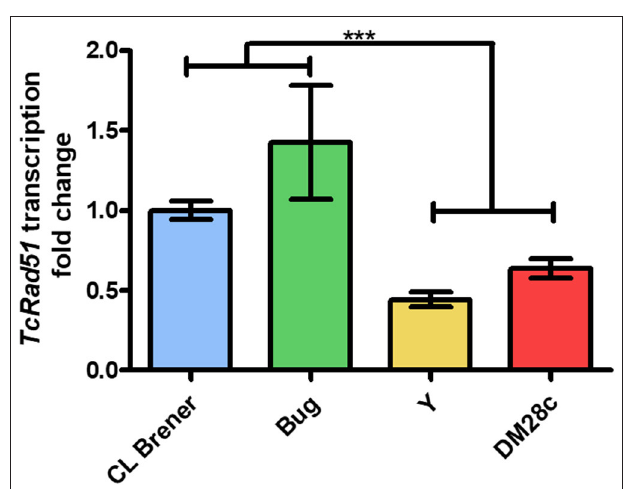
FIGURE 6 | Relative expression of TcRAD51. Fold change of TcRAD51 transcription using CL Brener strain as control strain using qRT-PCR assay. Results of three distinct experiments are shown. Asterisks indicate statistically significant differences among groups ( P -value < 0.05).